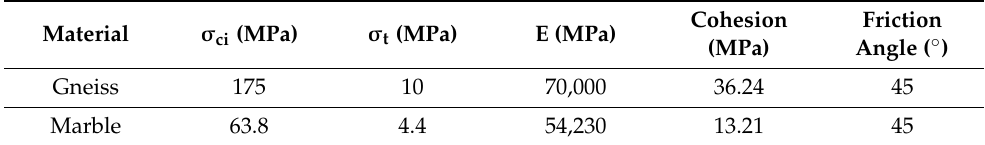
Table 4. The list of examined materials and some of their main properties.